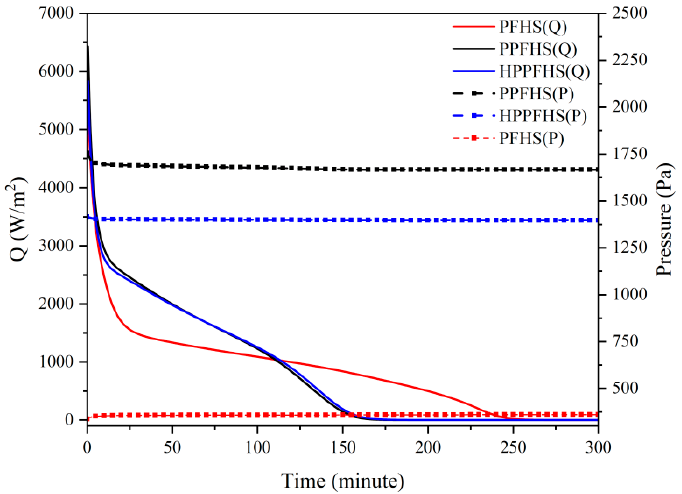
Figure 7. Heat flux (Q) of thin shells and pressure (P) at the inlet of the flow channel over time of three kinds of reactors (dehydration, ε = 0.5, u = 25 m/s).